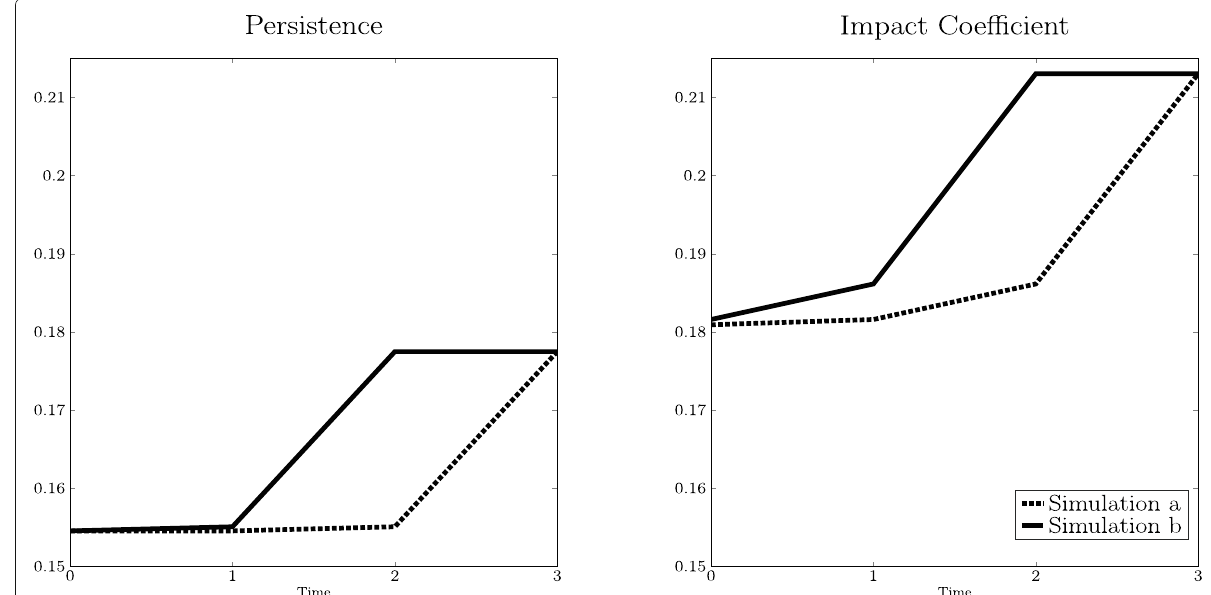
Fig. 3 The optimal monetary policy rule. The optimal persistence parameter a j t (left panel) and the optimal impact coefficient ˆ h j t in the policy rules for both simulation j = { a , b } with ρ u = 0.95. Simulation a (dashed lines) assumes central bank credibilities { γ a t } T + 1 t = 0 = { 1,1,1,0 } and simulation b (solid lines) assumes central bank credibilities { γ b t } T + 1 t = 0 = { 1,1,0,0